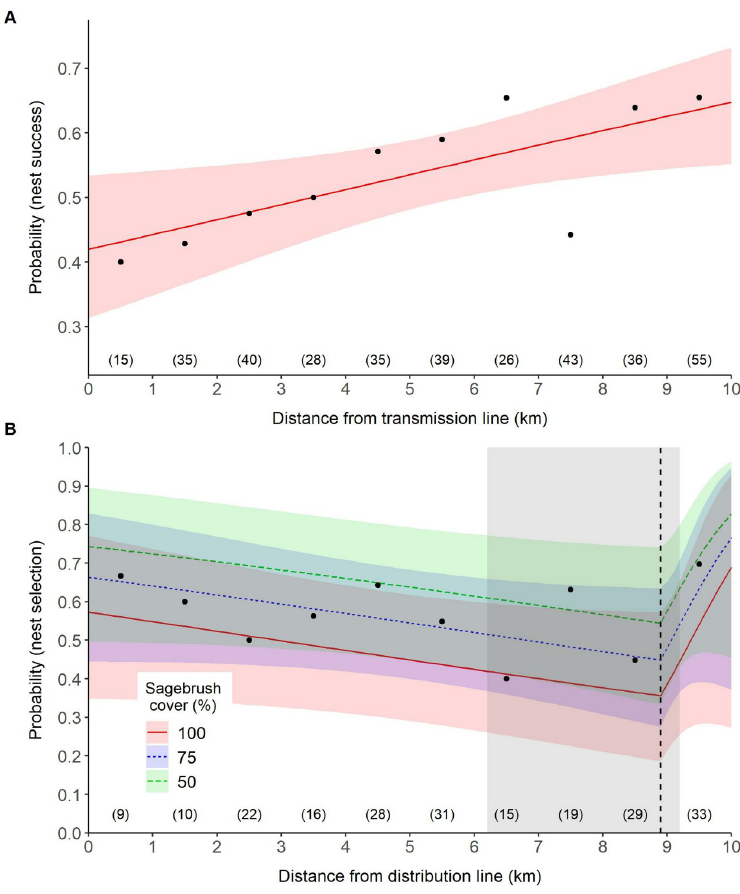
Fig 5. Effect of power lines on the greater sage-grouse ( Centrocercus urophasianus ; sage-grouse) in Utah, portions of southeastern Idaho, and southwestern Wyoming, USA, 1998–2013. Lines are population-averaged fitted values from the best-fit GLMM (S5 Appendix) describing the effects of transmission lines (A) and distribution lines (B) on sage-grouse nest success. The vertical dashed line identifies the response threshold at which sage-grouse response changes. The shaded areas highlight uncertainty ( Δ AICc < 2) around the location of the response threshold. Circles represent a binning of data points that informed the model; sample sizes within each 1 km bin are identified in parentheses. For example, 15 nests were recorded between 0–1 km from a transmission line, of which 40% (n = 6) persisted.